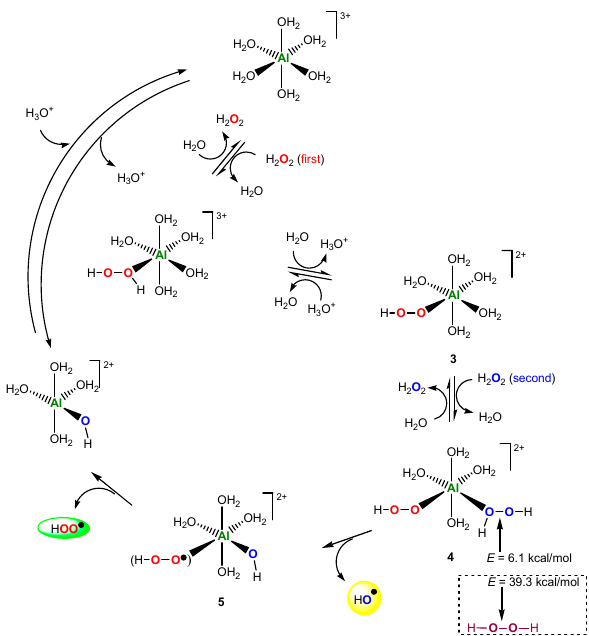
Figure 3. The Al ‐ catalyzed decomposition of hydrogen peroxide. Adapted from Ref. [162]. Figure 3. The Al-catalyzed decomposition of hydrogen peroxide. Adapted from Ref.